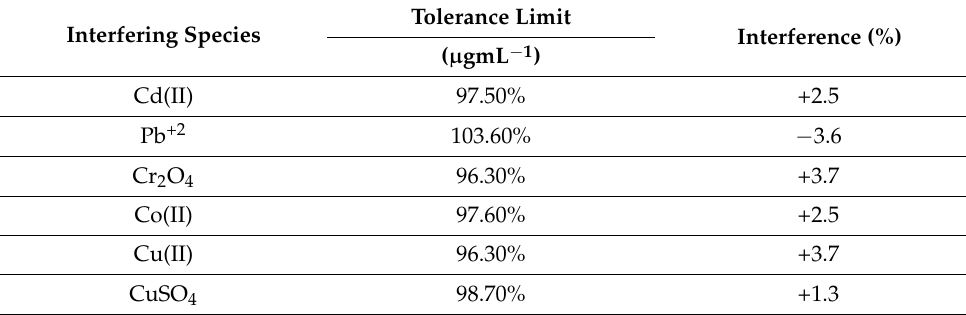
Table 2. Maximum tolerable limits of interfering species for Hg 2+ .